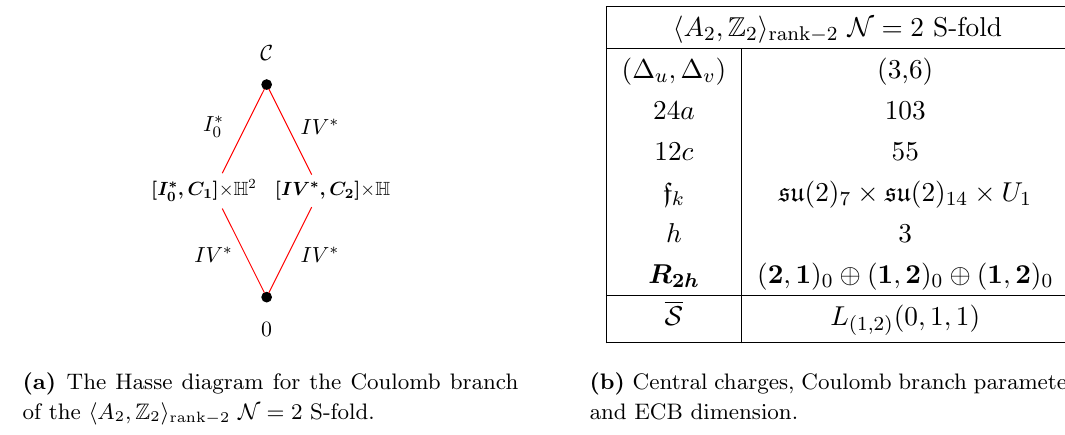
Figure 22. Information about the h A 2 ; Z 2 i rank (cid:0) 2 N = 2 S-fold.